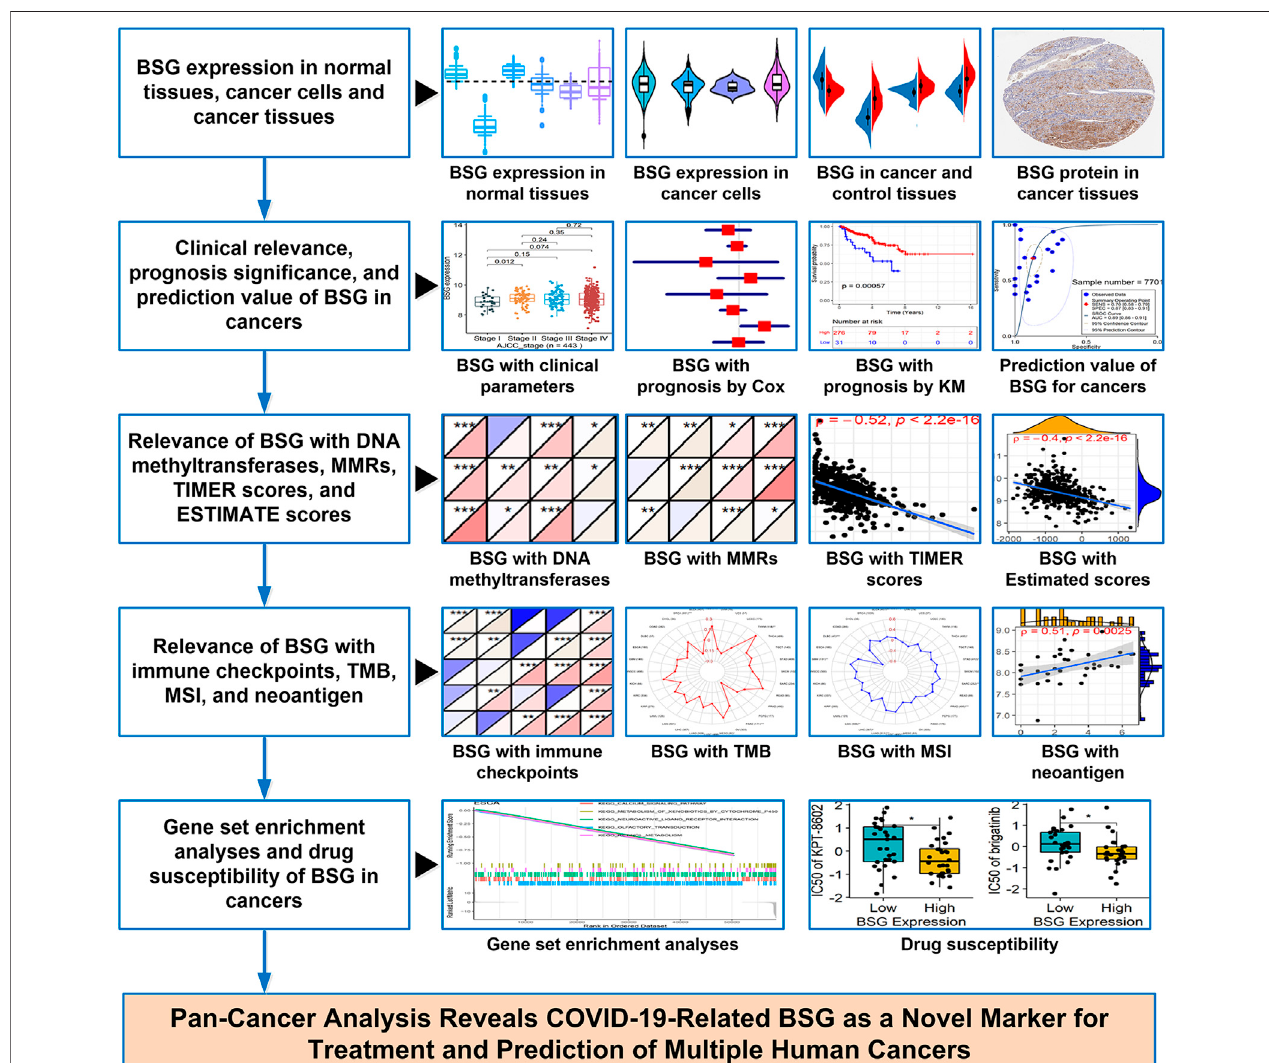
FIGURE1| Over fl owofthisstudy.BSG,basigin; “ Cox ” representsCoxregressionanalysis; “ KM ” representsKaplan – Meiercurves;MMRs,mismatchrepairgenes; TMB, tumor mutational burden; MSI, microsatellite